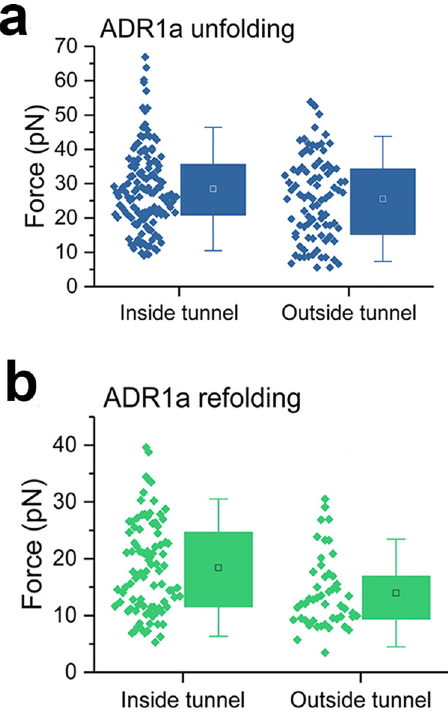
Fig. 3 Unfolding and refolding of ADR1a with the optical tweezers in the presence of Zn 2 + . a Unfolding and b folding force distributions of ADR1a inside and outside of the ribosomal tunnel. The box plots show the interquartile range of the data between the 25th and 75th percentiles, the black/white squares represent the mean and the whiskers the standard deviation; the individual data points are plotted alongside.